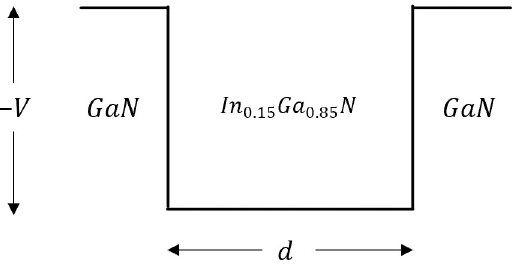
Fig 1. Schematic diagram of a typical GaN/InGaN/GaN double barrier quantum well structure. The width d of the InGaN layer is set initially to 5 nm for the scattering rates numerical calculations. The well depth v of 0.5 eV represents the discontinuity between the conduction bands of InGaN and GaN. The values reported for the conduction band energies ( E ) are -2.8 eV and -2.3 eV for GaN and InGaN based on DFT calculations C